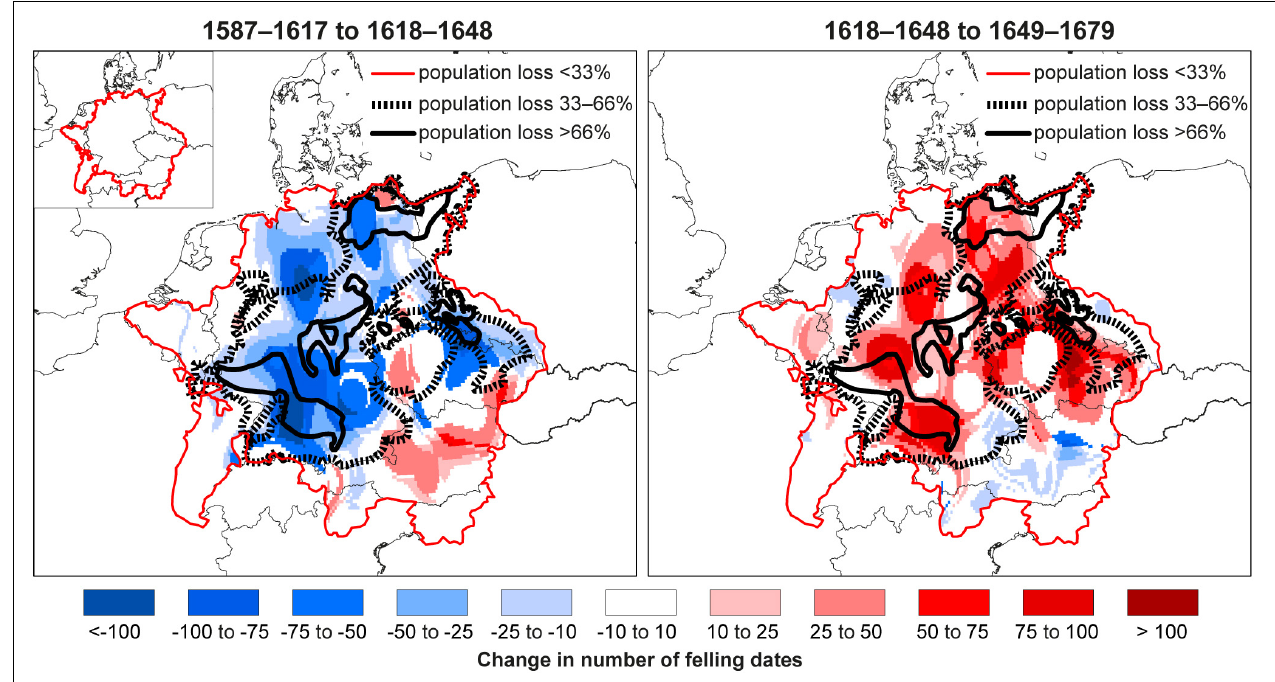
FIGURE 6 | Changes in the number of felling dates for three 31-year periods of the time of the Thirty Years’ War (1618–1648) to the period 1587–1617 and to the period 1649–1679 CE. The maps are shown with contemporary political boundaries. Regions with a population loss of 66% and above, of 33–66%, and below 33% are shown on the map.